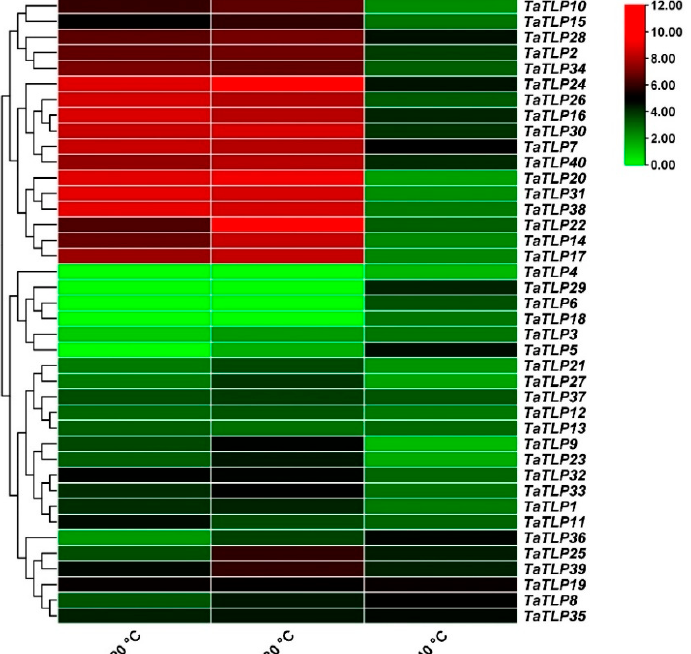
Figure 6. Heatmap representing expression analysis of TaTLP genes in wheat subjected to different temperatures.